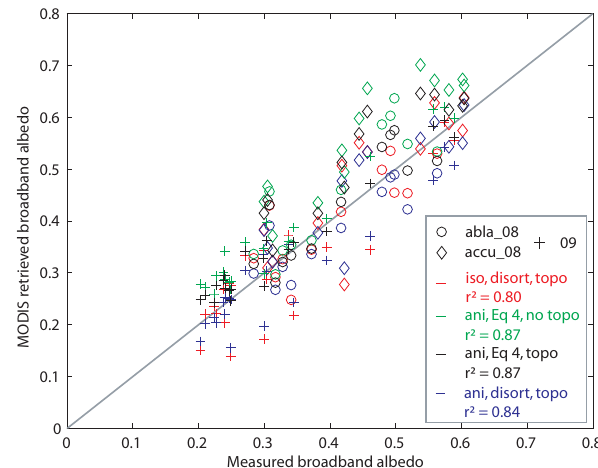
Fig. 2. Measured broadband albedo values versus MODIS retrieved albedo. The different symbols are for 1/diamonds, accumulation zone, summer 2008, 2/circles, ablation zone, summer 2008 and 3/crosses, ablation zone, summer 2009. The colours correspond to the method used to retrieve the albedo value and the determination coefficient, r 2 , for each of the methods is also given in the legend of the figure. The 1 : 1 ratio line is indicated in